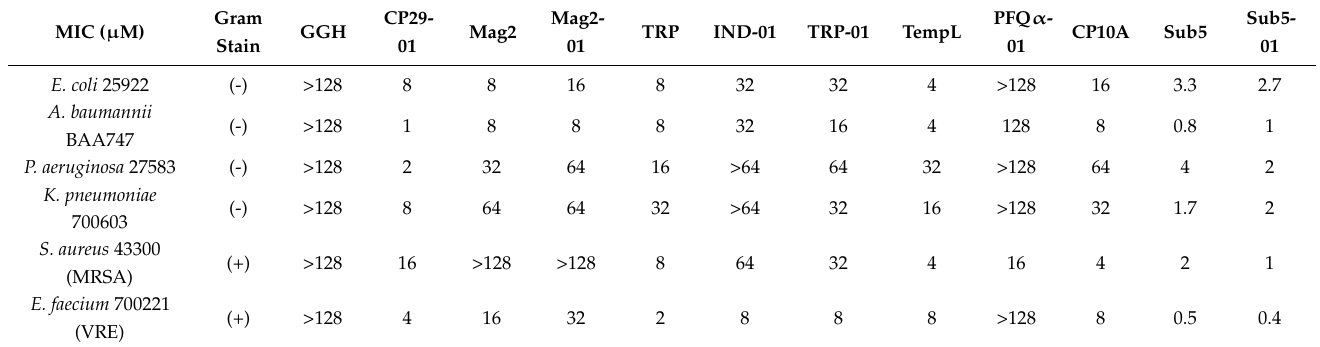
Table 4. MIC values for antimicrobial peptides utilized in this study. MIC values for a variety of the presented peptides have been previously determined in alternative conditions; values here are the result of experimental efforts to determine MICs under the conditions utilized for further study of FIC potential, with the exception of Sub5 and Sub5-01, previously characterized in our laboratory, which have been taken from reference